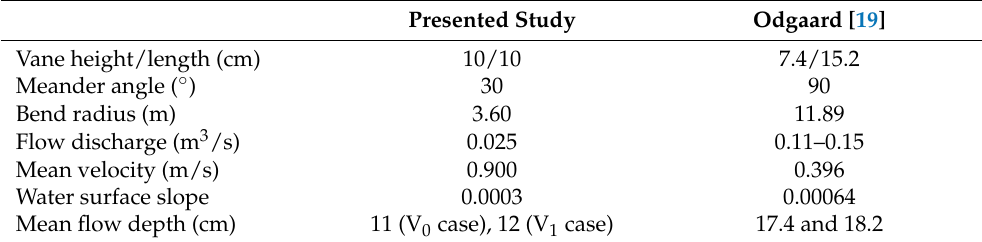
Figure 3. According to “with vane” situation, all sections and points measured in the channel. Table 2. Presented submerged vane and previously experimental